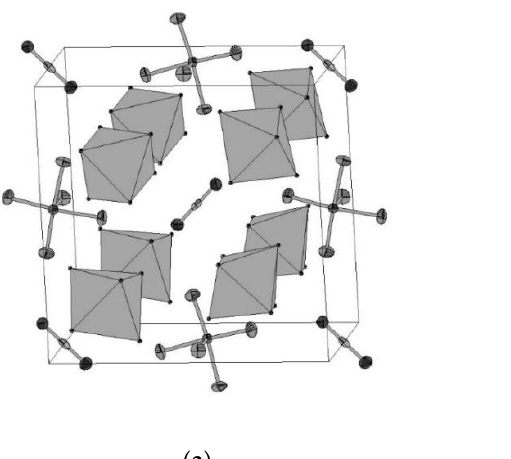
( b ) Figure 14. ( a ) Part of the crystal structure of  -XeF 5 Pd(SbF 6 ) 3 (296 K). Disorder of [XeF 5 ] + cations is not depicted. Only F atoms involved in secondary Xe···F contacts are labeled; ( b ) Packing of the columns in the crystal structure of (XeF 5 ) 3 [Hg(HF)] 2 (SbF 6 ) 7 with a triclinic unit cell. Copyright (2016) Wiley. Used with permission from Ref. [40]. 2.3. Xenon(VI) Oxide Compounds One of the main obstacles in the research of XeO 3 is its extreme sensitivity. Solid XeO 3 detonates when subjected to mild thermal or mechanical shock. For these reasons, experiments are usually limited to small quantities of XeO 3 and its compounds (up to 20 mg).